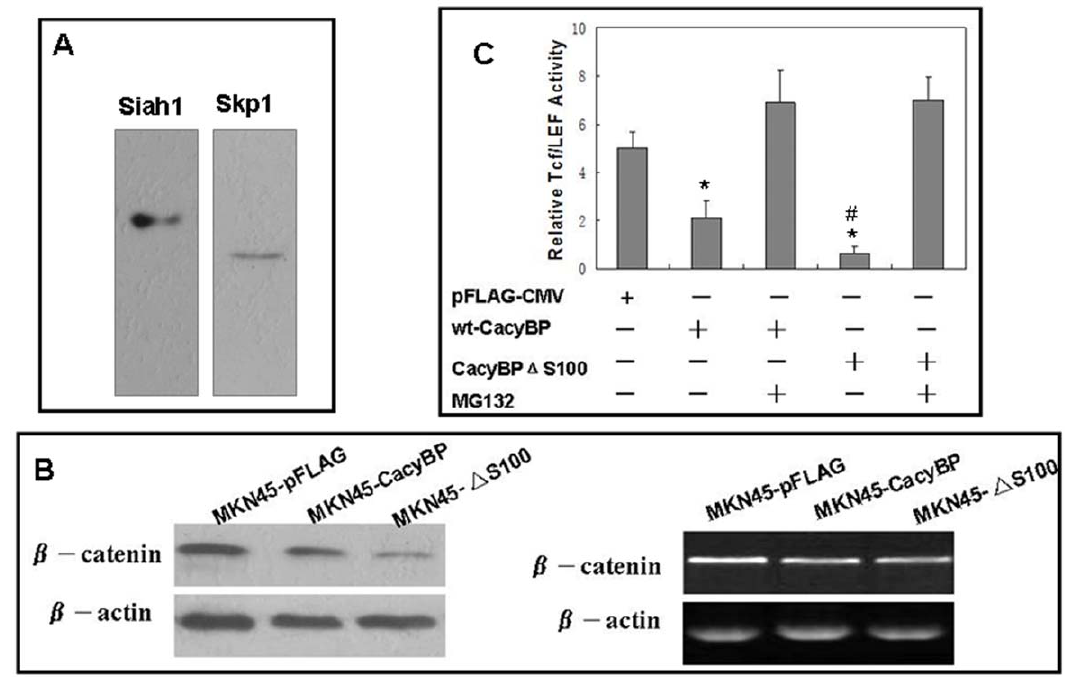
Figure 5. Effects of S100A6 on CayBP/SIP-mediated b –catenin degradation. (A) Co-immunoprecipitation assay showed that truncated mutant CacyBP/SIP D S100 bind both Skp1 and Siah1, suggesting S100A6 did not affect the formation of Siah1-CacyBP/SIP-Skp1 unbiquitin ligase complex. (B) Western blot and semi-quantitative RT-PCR were used for analysis of b -catenin protein and mRNA in transfected cells, respectively. b – catenin protein in MKN45- D S100 cells is significantly decreased, compared to MKN45-CacyBP cells, while with no change occurred in the mRNA. (C) The luciferase reporter gene assays were used to evaluate effect of CacyBP/SIP D S100 on Tcf/LEF reporter activity. Transfection of wild-type CacyBP/ SIP decrease the Tcf/LEF activity, compared to control plasmid. And expression of CacyBP/SIP D S100 resulted in lower Tcf/LEF activity than wild-type CacyBP/SIP. MG132 (inhibitor of proteasome) could eliminate the effect of both wild-type CacyBP/SIP and CacyBP/SIP D S100 on Tcf/LEF activity. * P , 0.01, compared with the control; # P , 0.05, CacyBP/SIP D S100 vs. wild-type CacyBP/SIP. These experiments were repeated in